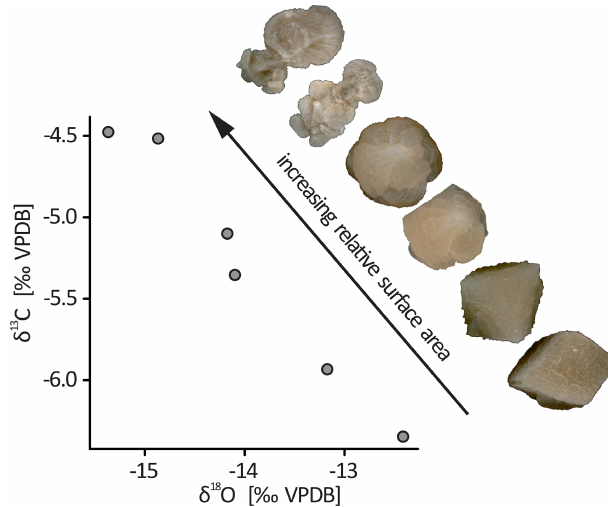
Figure 2. Stable isotope compositions of selected crystals from patch 1. The data follow a trend with a negative slope, which is typical for CCCs. The stable isotope composition changes system- atically with the progression from rhombohedral to radially branch- ing morphologies. All depicted samples are between 2 and 5mm in diameter, but the images were rescaled for better